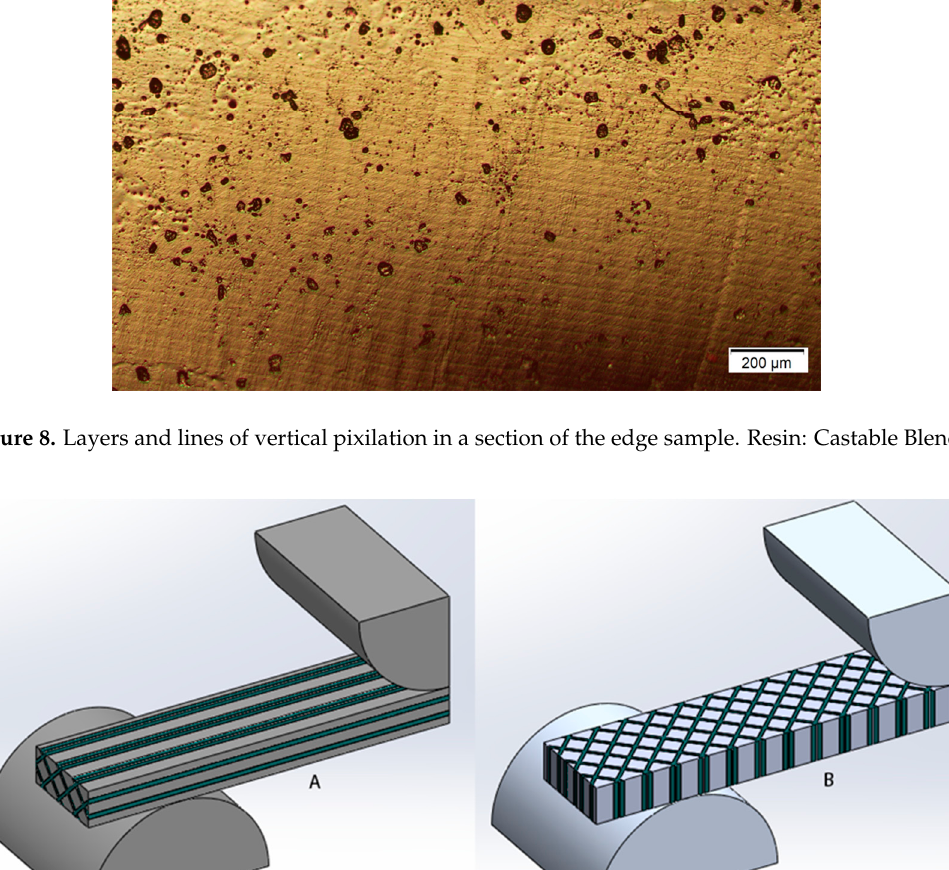
Figure 9. Samples with columns due to pixilation. ( A ) Made under vertical direction; ( B ) Made under horizontal direction.